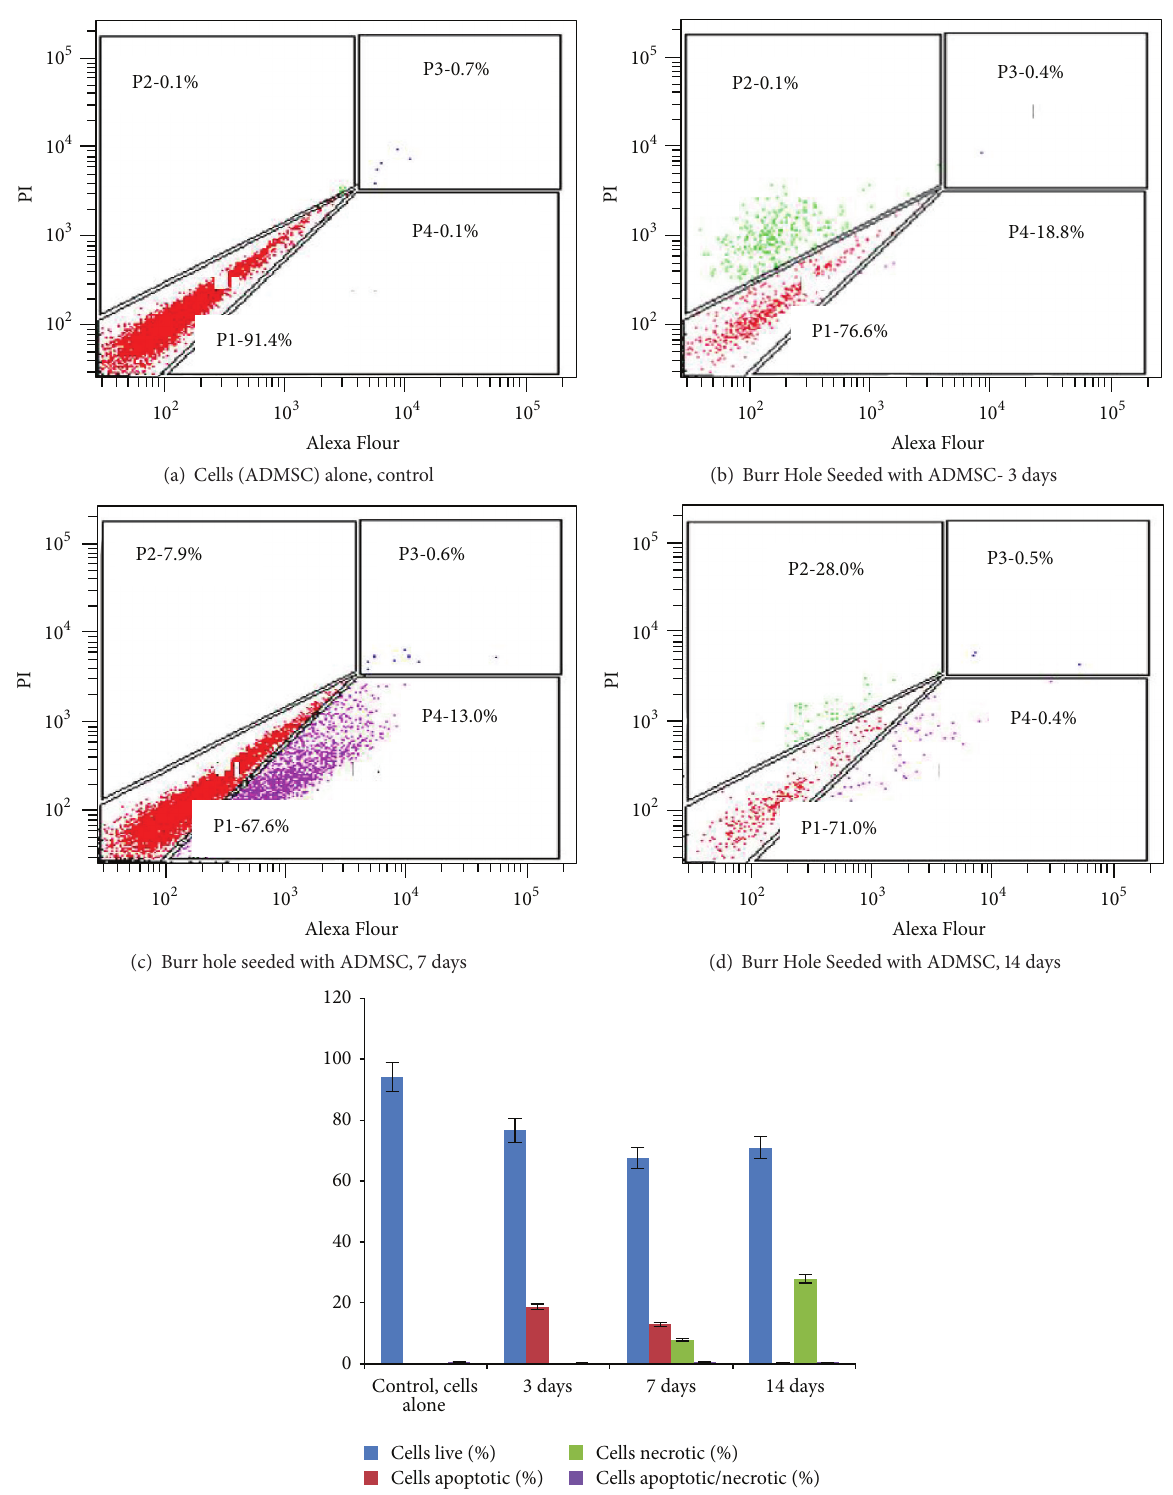
Figure 7: Flow cytometry evaluation for apoptosis of ADMSCs seeded onto the device. Annexin V assay. (a) Unstained ADMSCs control; (b) 3 days; (c) 7 days; (d) 14 days; (e) graphical representation of quantitative data ( 𝑛 = 3 ). All values are expressed as mean ± SD from three different